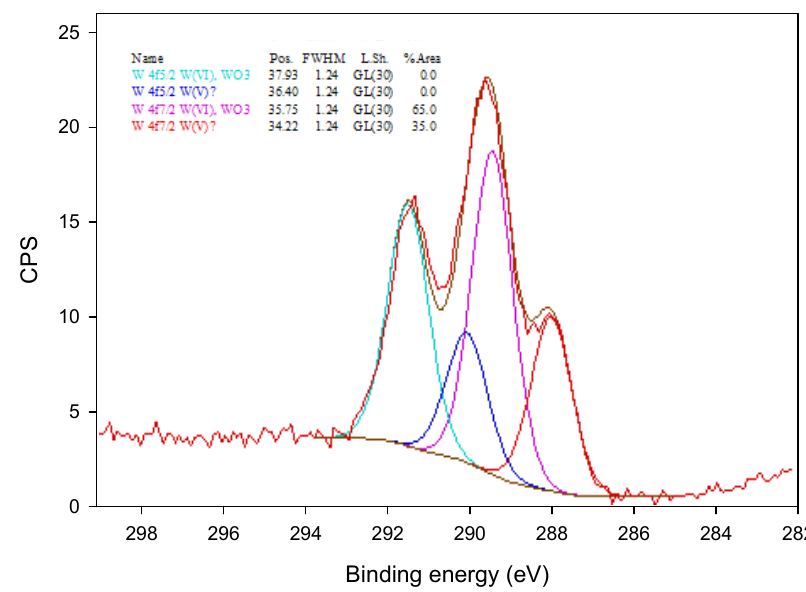
Figure 4. The XPS spectrum of organic network of the membrane.